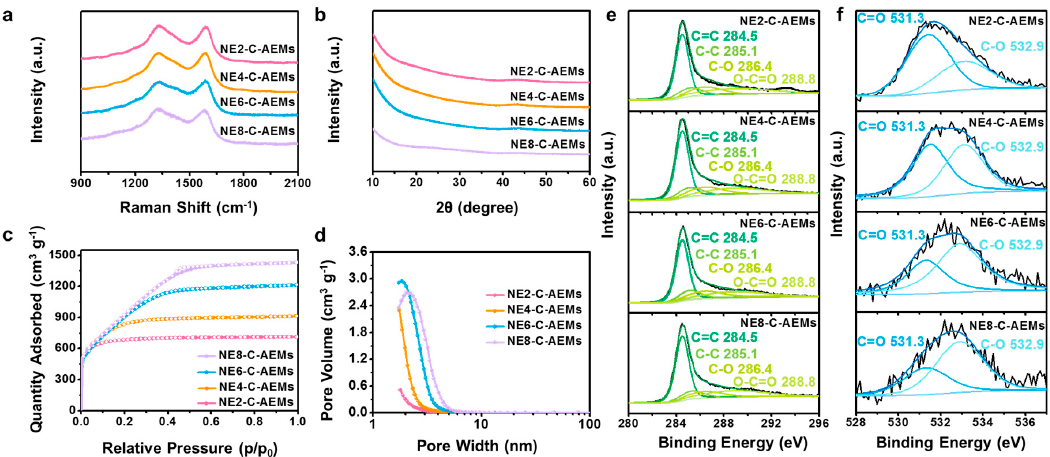
Figure 3. Material properties of the NE-C-AEMs. ( a ) Raman spectra, ( b ) XRD patterns, ( c ) Nitrogen adsorption and desorption isotherm curves, ( d ) Pore size distribution data, and XPS ( e ) C 1s and ( f ) O 1s spectra.